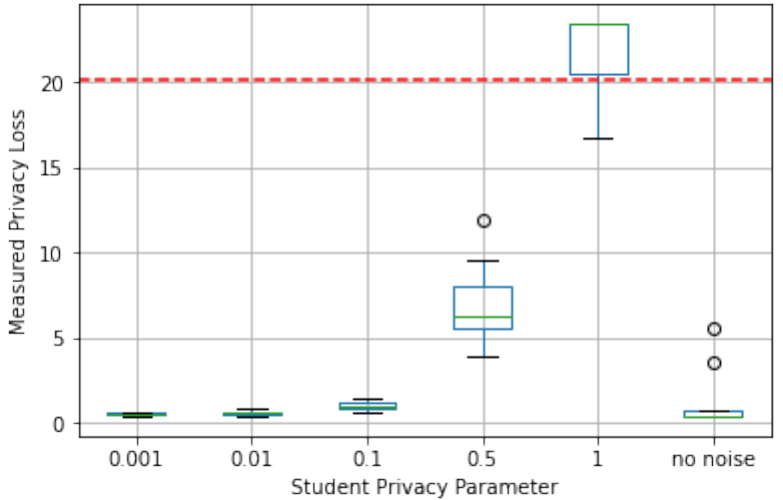
Figure 15. Privacy loss by student privacy parameter ρ in Web Requests